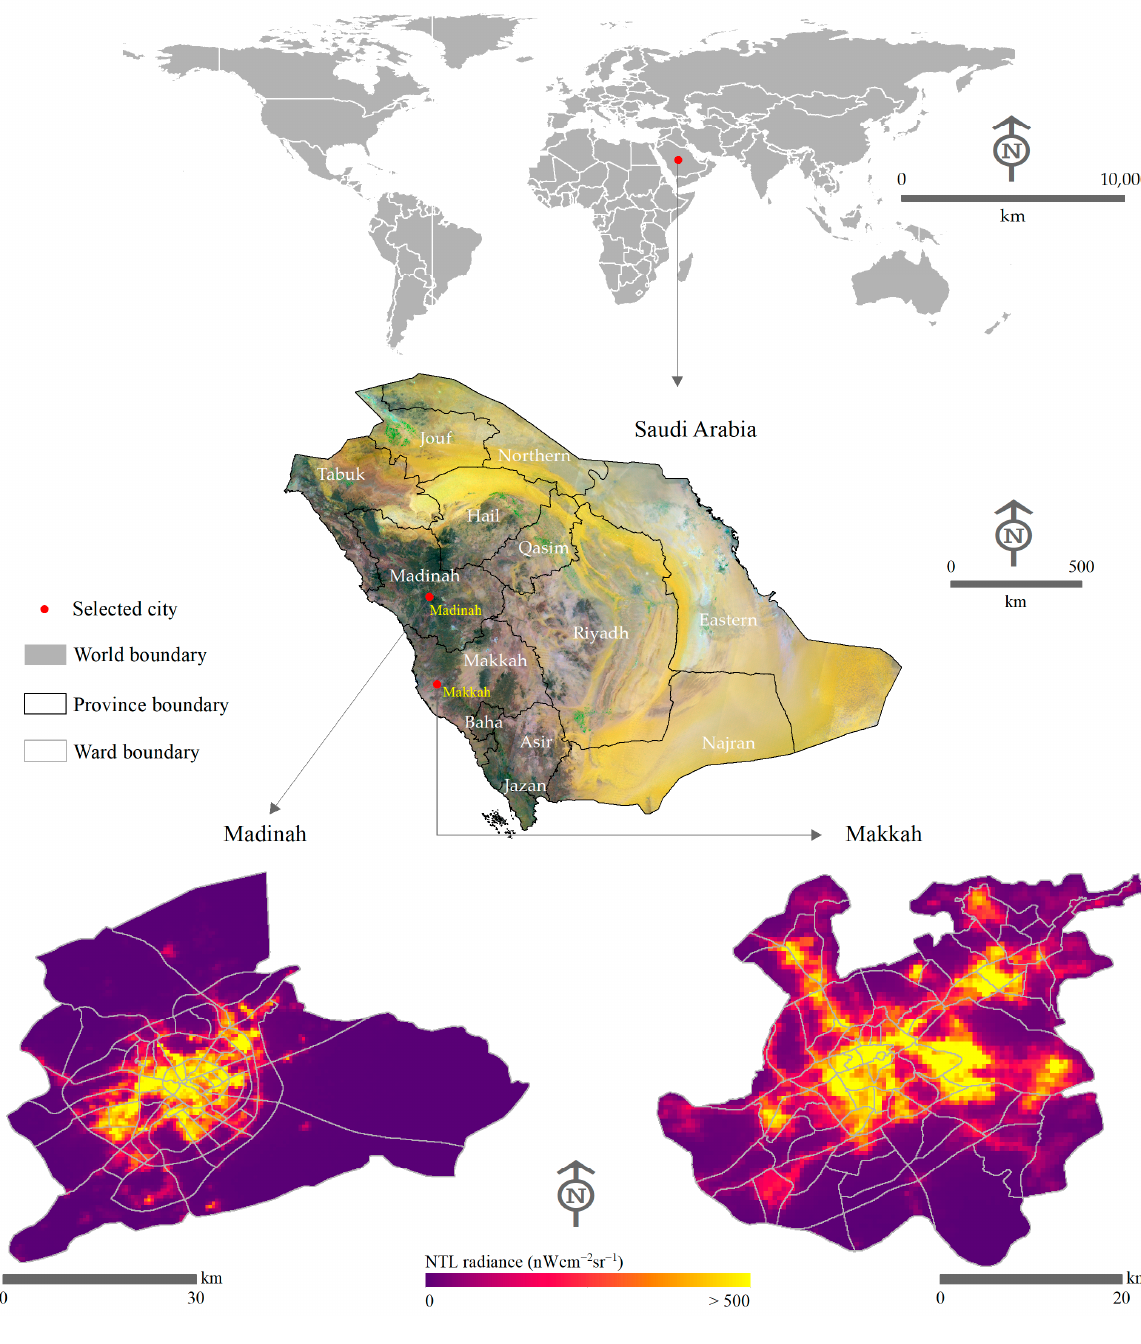
Figure 1. Site location of Makkah and Madinah cities.